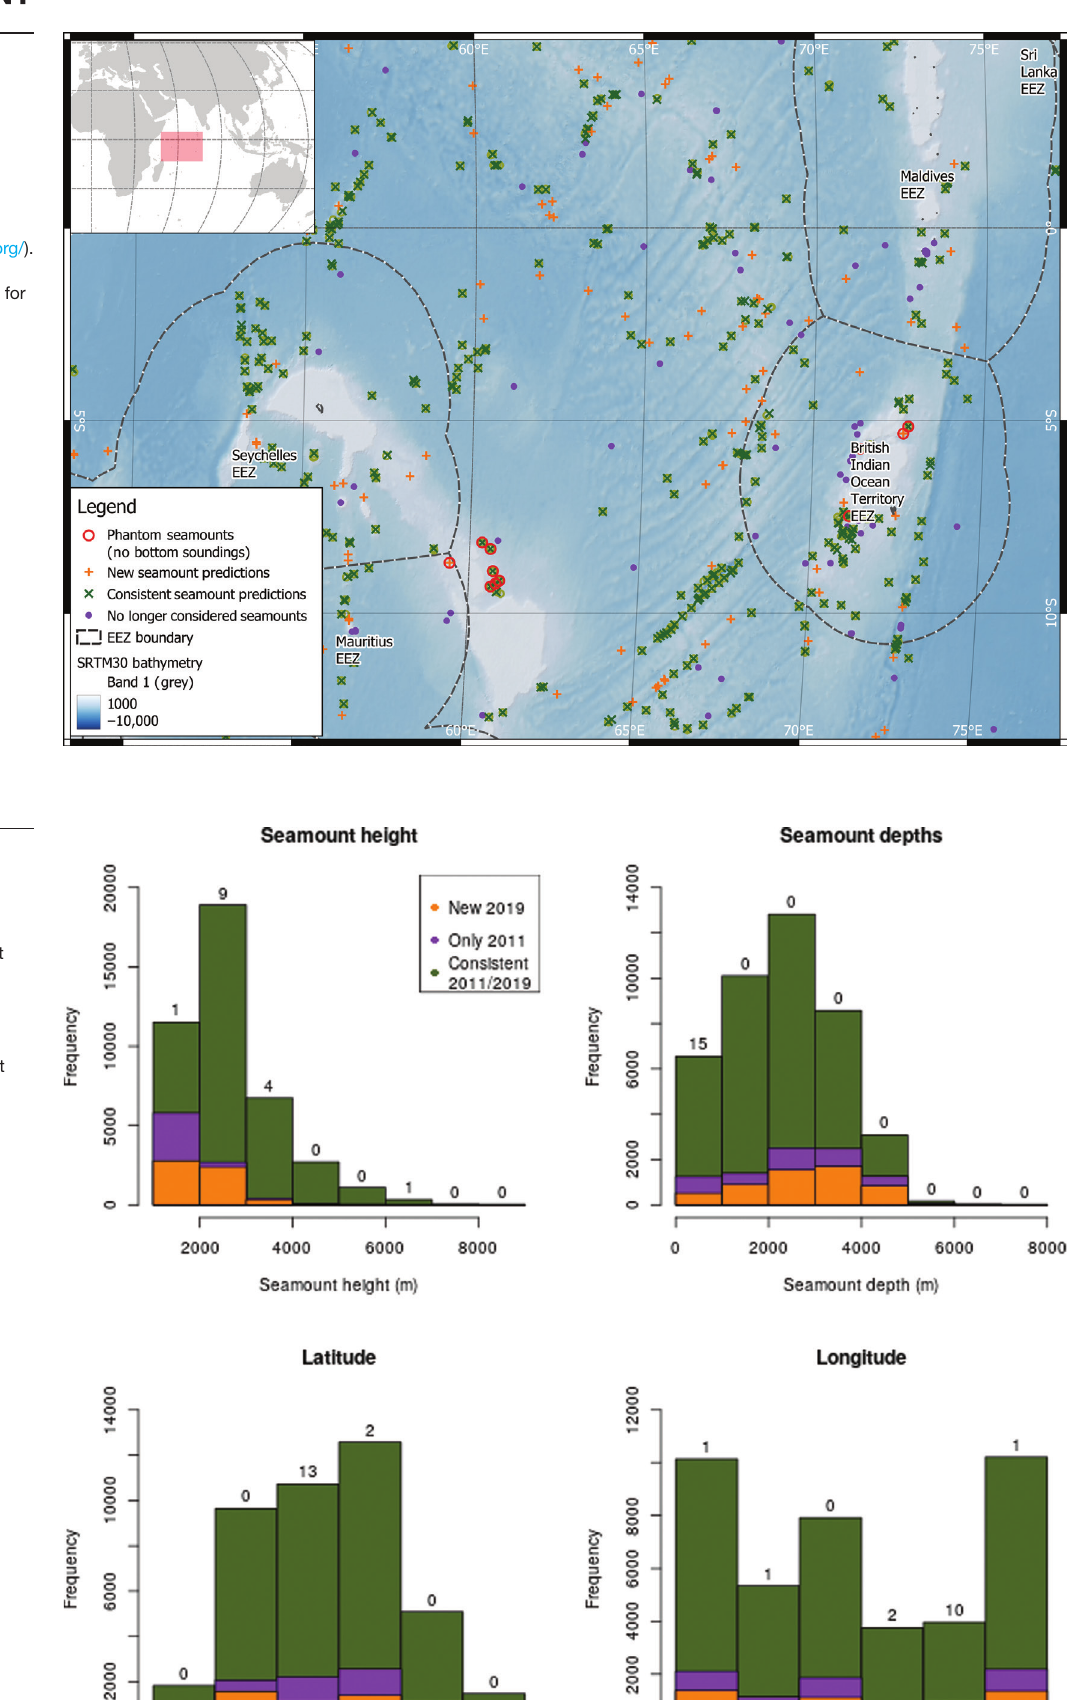
Focus on seamounts of NW Indian Ocean. Most of the 15 predicted seamounts based on no bottom soundings are in the Indian Ocean. EEZ are exclusion economic zones (boundary of national jurisdiction – source https://www.marineregions.org/). Robinson map projection (EPSG:54030). Lat/long lines shown for reference.